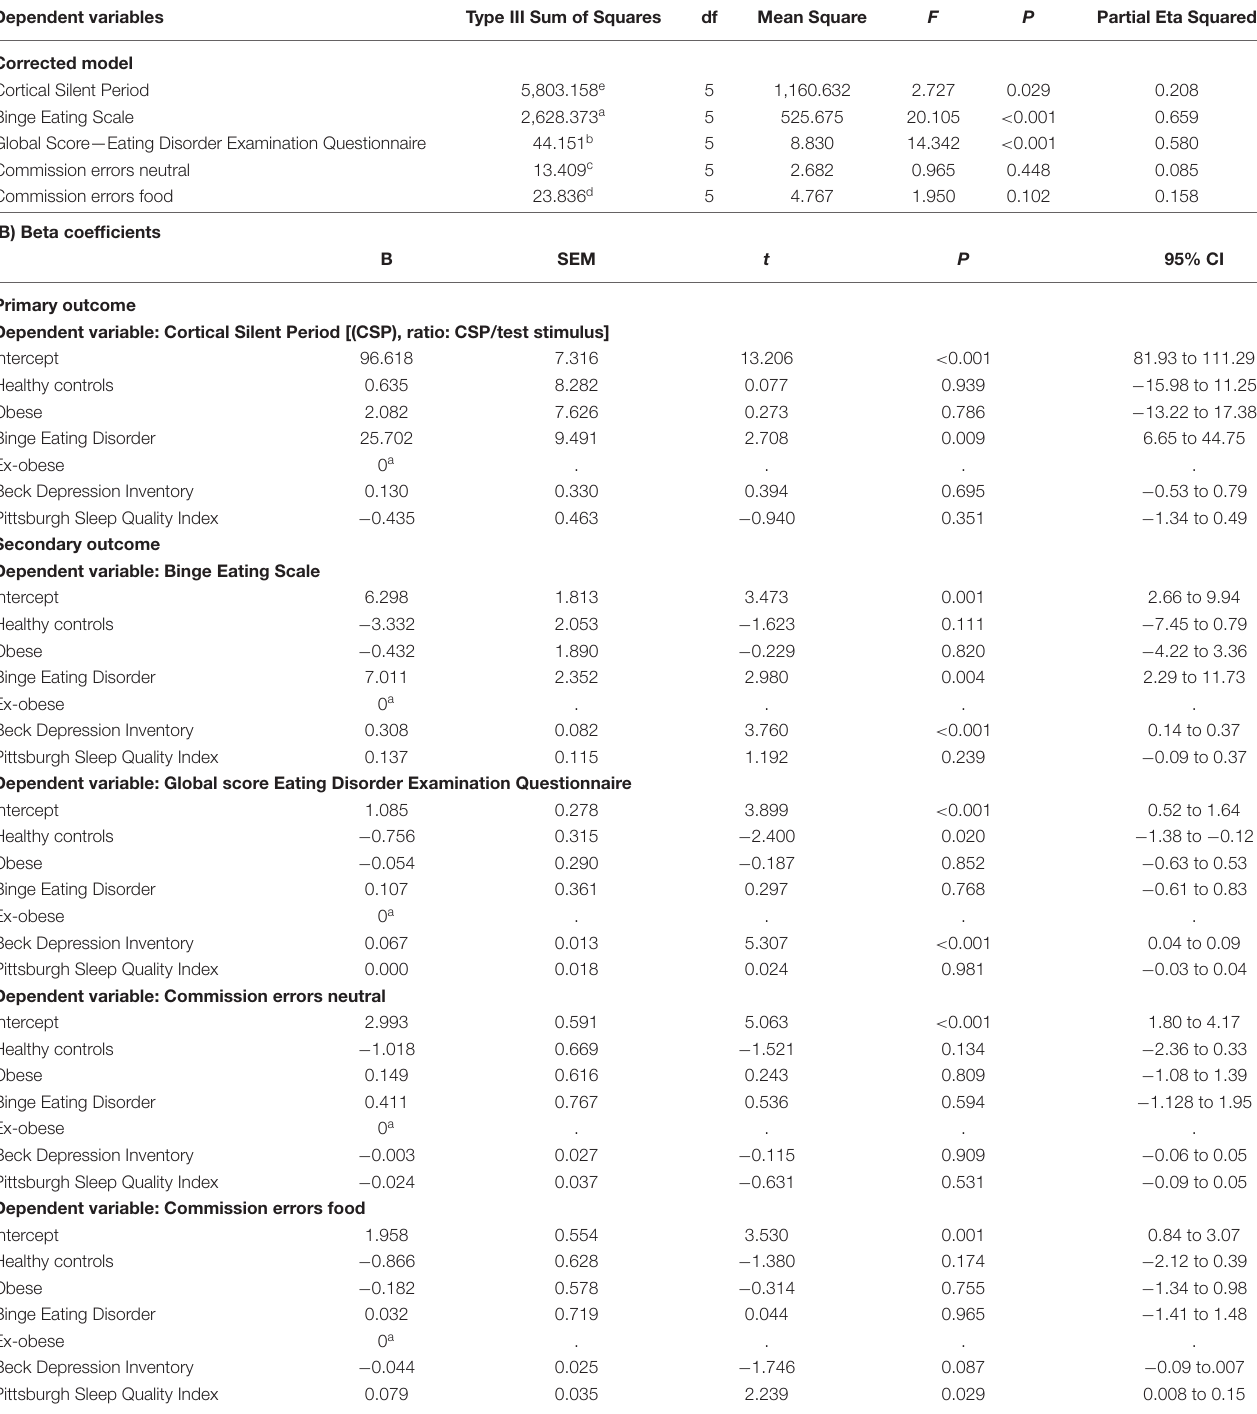
TABLE 4 | Multivariate linear regression model of the cortical inhibition and eating psychopathology according to clinical and non-clinical groups ( n = 59). (A) Main